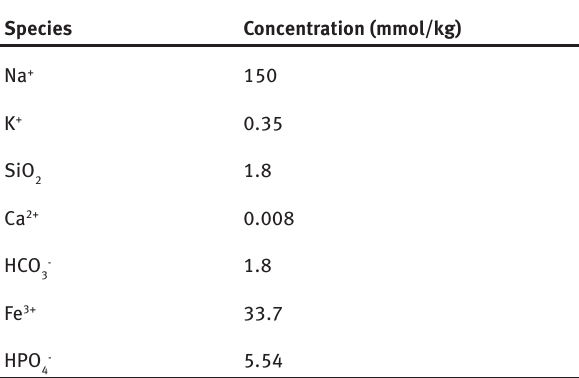
Table 1: Concentrations of sediment porewater species used